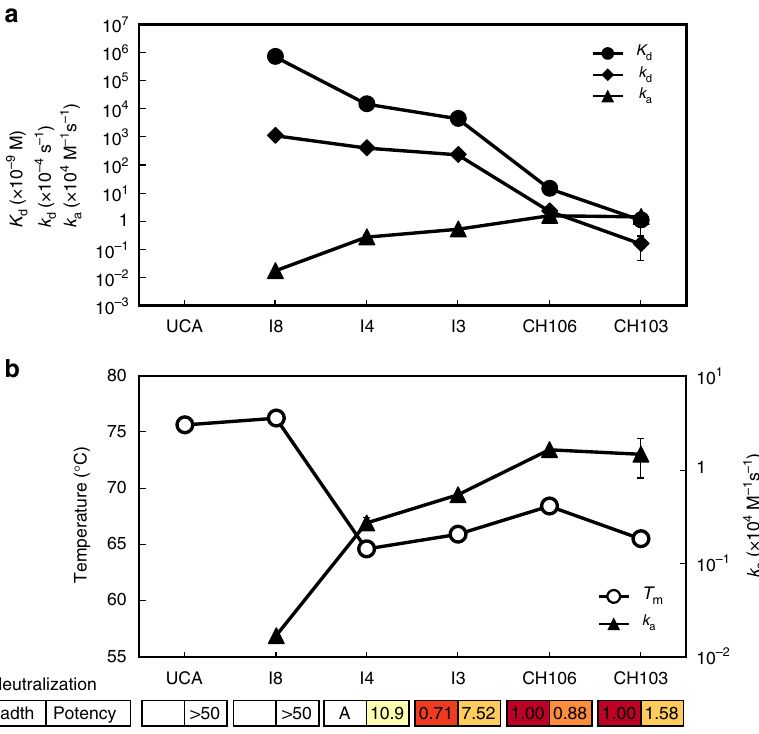
Fig. 4 Af fi nity and thermal stability trade-off in the CH103 bnAb lineage. a Apparent af fi nity ( K d , circles) and kinetic association ( k a , triangles) and dissociation rates ( k d , diamonds) of CH103 lineage mAbs binding to HIV-1 Env B.63521 gp120 (heterologous Env) show changes in kinetic rates during af fi nity maturation. CH106 and CH103 mAbs bound to Env with high af fi nity ( K d < 20 nM) and demonstrated breadth in neutralization 24 . b The initial improvement in the association rate ( k a , y 2 -axis, closed triangles) for binding to heterologous Env (B.63521) occurs at the I8 – I4 transition and coincides with the observed reduction in antibody thermal stability (T m , y 1 -axis, open circles). Data are plotted as the mean and standard deviation from a minimum of two replicate measurements. Certain error bars are smaller than the data markers at this scale. Boxes depict the neutralization breadth and the geometric mean potency (IC 50 , μ g/mL) calculated from previously published data 24 . A value of 50 was used for those with IC 50 > 50. An “ A ” for the neutralization breadth indicates the antibody neutralizes autologous virus